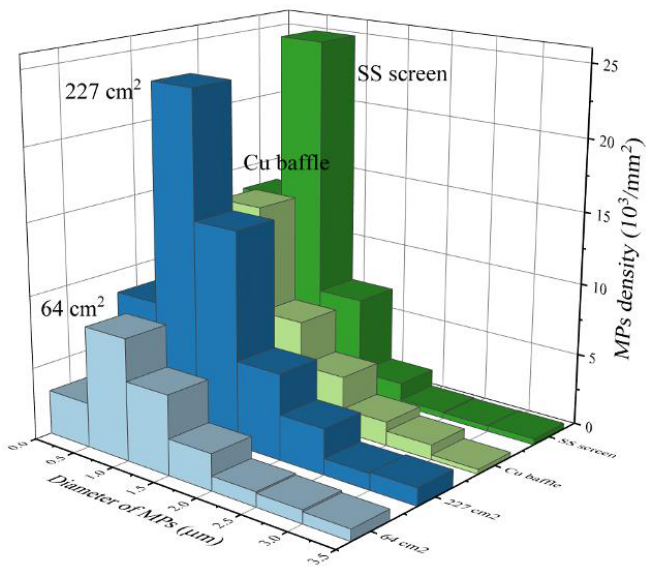
Figure 6. Distribution of MP density with different inner wall structures and different cross-section areas of 227 and 64 cm 2 .